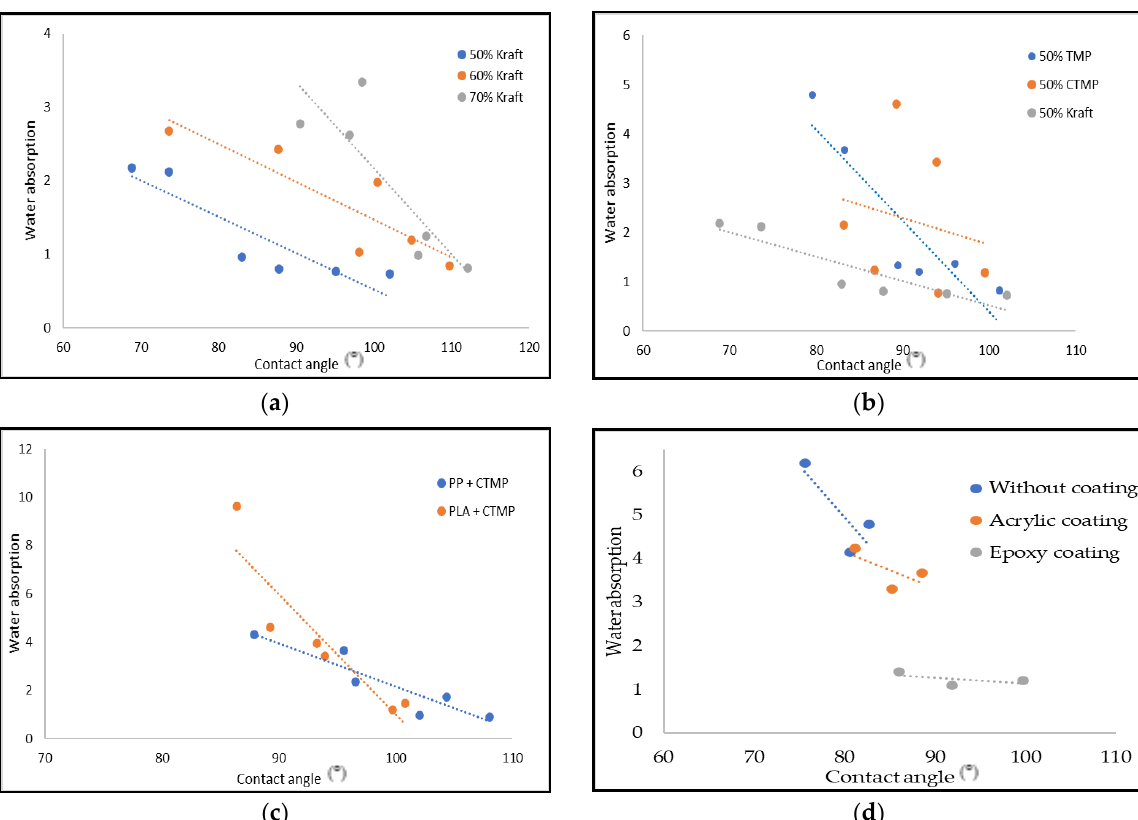
Figure 4. Relationship between water absorption and contact angle for composites made with ( a ) Kraft and different fiber content (50–70%); ( b ) filled with 50% of different fiber type (kraft, TMP, and CTMP); ( c ) CTMP with different matrixes (PP, PLA), and ( d ) coated and uncoated TMP-PLA biocomposites at 50, 60, and 70% proportions.